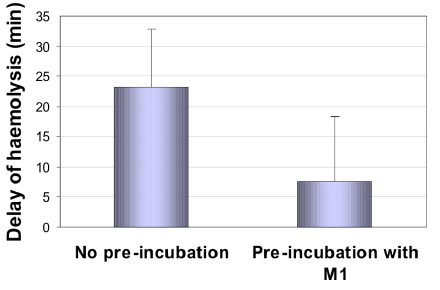
Figure 6. Protection of erythrocytes against oxidative haemo- lysis in the presence of M1. Haemolysis of a 1% human erythrocytes suspension in the presence of the metabolite M1 (1 m M) was determined in an AAPH-assay. Erythrocytes were either co-incubated with M1 (left column) or pre-incubated with M1 for 60 min (right column), and delay of haemolysis was determined with reference to an incubation mixture without addition of M1. Columns represent the mean and standard deviation of three